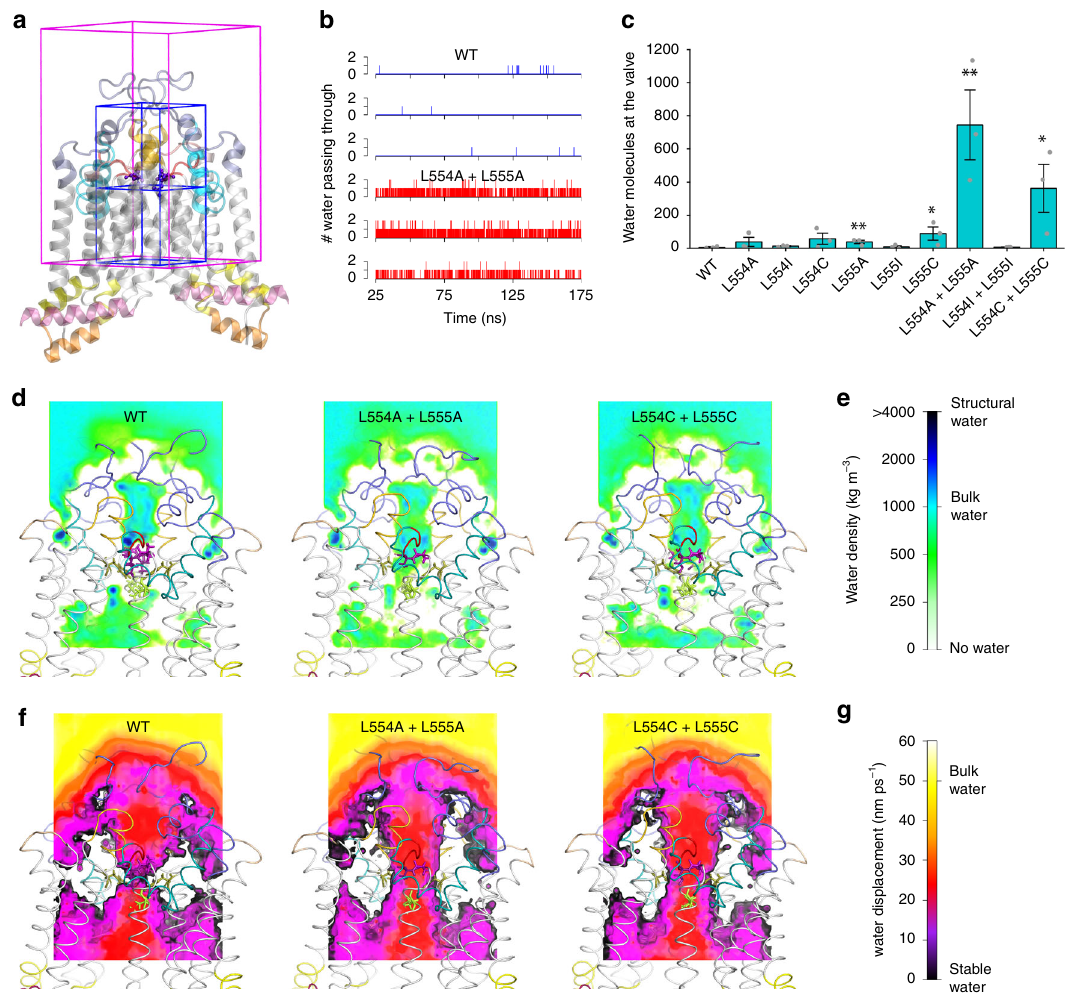
Fig. 5 The di-leucine valve regulates water fl ow between central and upper cavities. a The spatial density of water was calculated in a 4 × 4 × 6 nm box surrounding the di-leucine valve (full magenta box). Blue boxes of total size 2 × 2 × 4 nm sides were used to determine water fl ow through the leucine valve by counting the number of water molecules exchanges between the cavities, analyzed in consecutive trajectory frames separated by 10 ps. Box boundary coincides with the di-leucine valve. b Water molecules passing through the di-leucine valve vs. time in WT and L554A L555A double mutant simulations. c Number of water molecules passing through the leucine valve averaged over three parallel runs using 150 ns for analysis. All data are shown as mean ± SEM. ** P < 0.01 and * P < 0.1 vs. WT. Gray dots refer to values from independent experiment. d A slice of spatial water density shows water presence around the leucine valve and transport path in ABCG2. The map is the average of three parallel simulations using trajectories of 150 ns for the mutants and 500 ns for WT. e The color scale of the spatial water density is shown for d . f A slice of mean water displacement shows water dynamics around the leucine valve and transport path in ABCG2. The map is the average of three parallel simulations using trajectories of 150 ns for the mutants and 500 ns for WT. g The color scale for the mean water displacement is shown for f